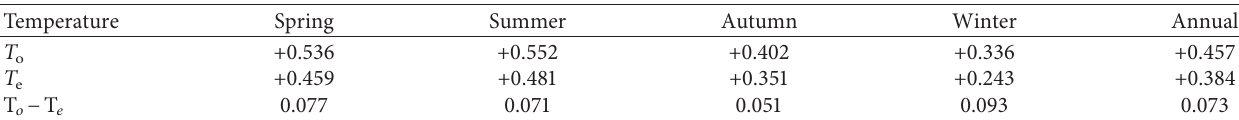
Figure 3: Average annual and seasonal mean temperature from station time series and ERA-Interim in the 1979–2017 period for QLM. The temperature trends are also shown for the two data sets. Table 4: Temperature warming trends ( ° C/decade) in all seasons from station time series and ERA-Interim reanalysis in